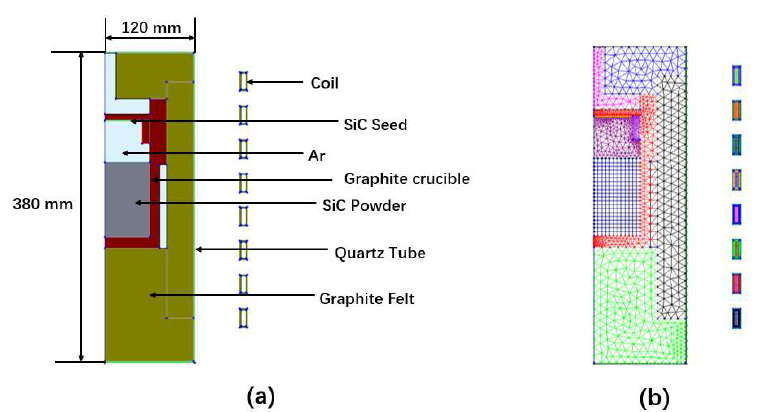
Figure 1. Crystal growth system in finite element calculations: ( a ) global model for the PVT growth of SiC single crystal. ( b ) the meshing of the calculation model.